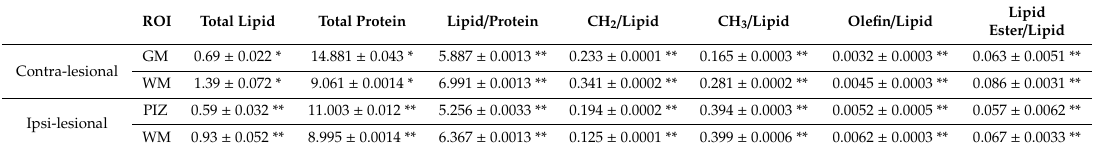
Table 2. Normalized values of biochemical components in regions of interest (ROI) at both sides. Total Total Lipid/ ROI Lipid Protein Protein 0.69 ± GM Contra- lesional 0.59 ± PIZ Ipsi- lesional